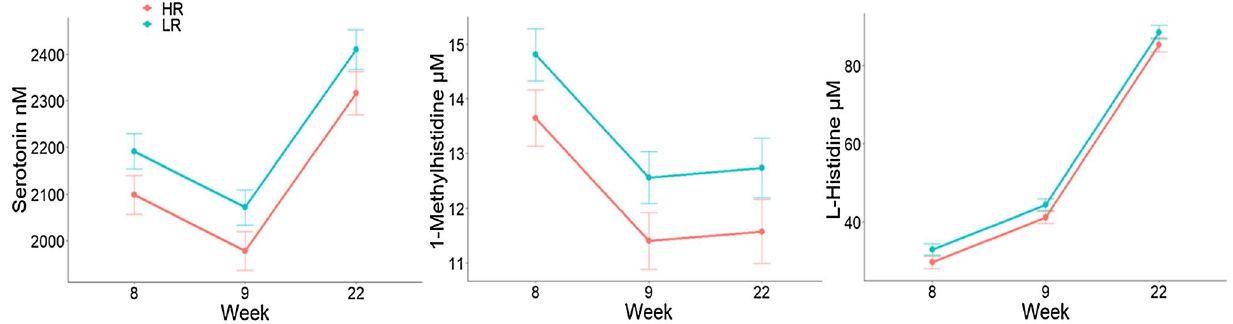
Figure 2. Least squared means and SE of serum metabolites and serotonin concentration in pigs with a high resisting (HR) and low resisting (LR) coping style at week 8, 9 and 22.